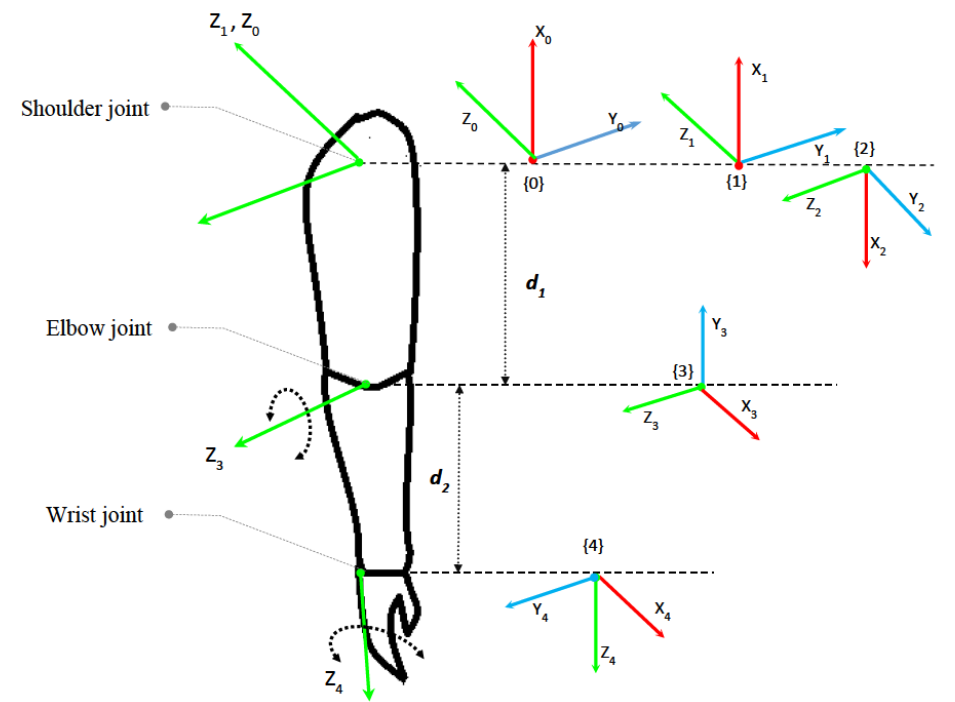
Figure 4: Coordinate frame assignment for Human upper arm